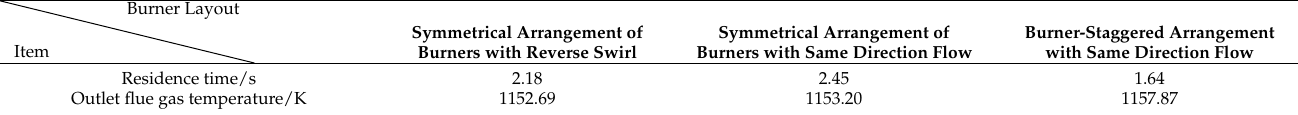
Table 2. Flue gas residence time and outlet flue gas temperature meter under different arrangement modes of burner.